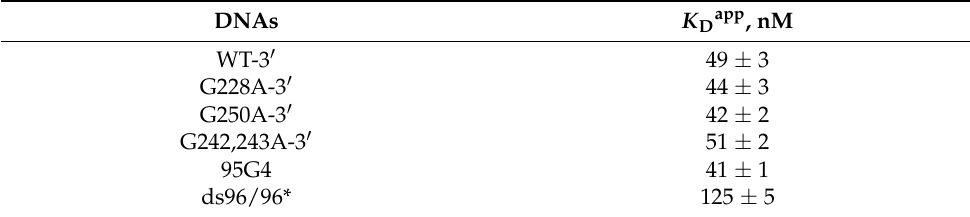
Table 2. Apparent dissociation constants ( K Dapp , nM) for ngMutL complexes with single-stranded 3 (cid:48) -TAMRA-labeled 96-nt WT and altered hTERT G4s.